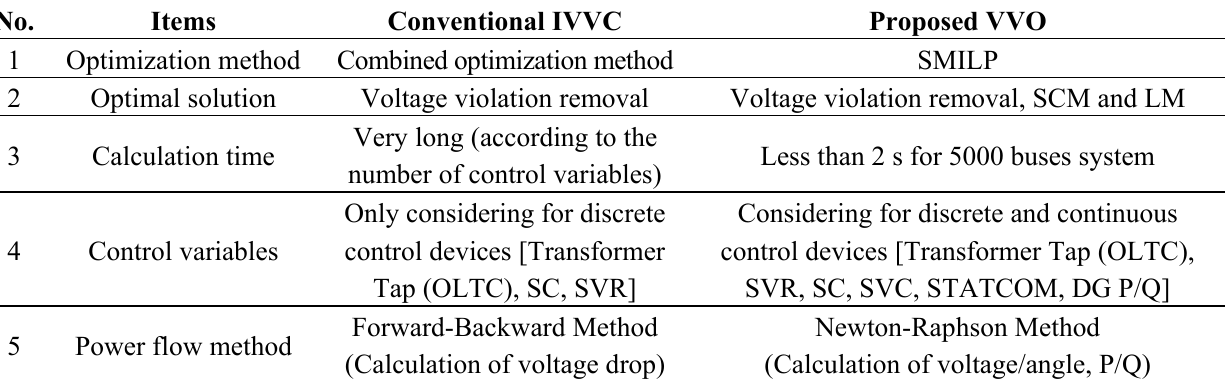
Table 1. Comparison with conventional integrated volt/VAR control (IVVC) and proposed voltage VAR optimization (VVO). SMILP: sequential mixed integer linear programming;